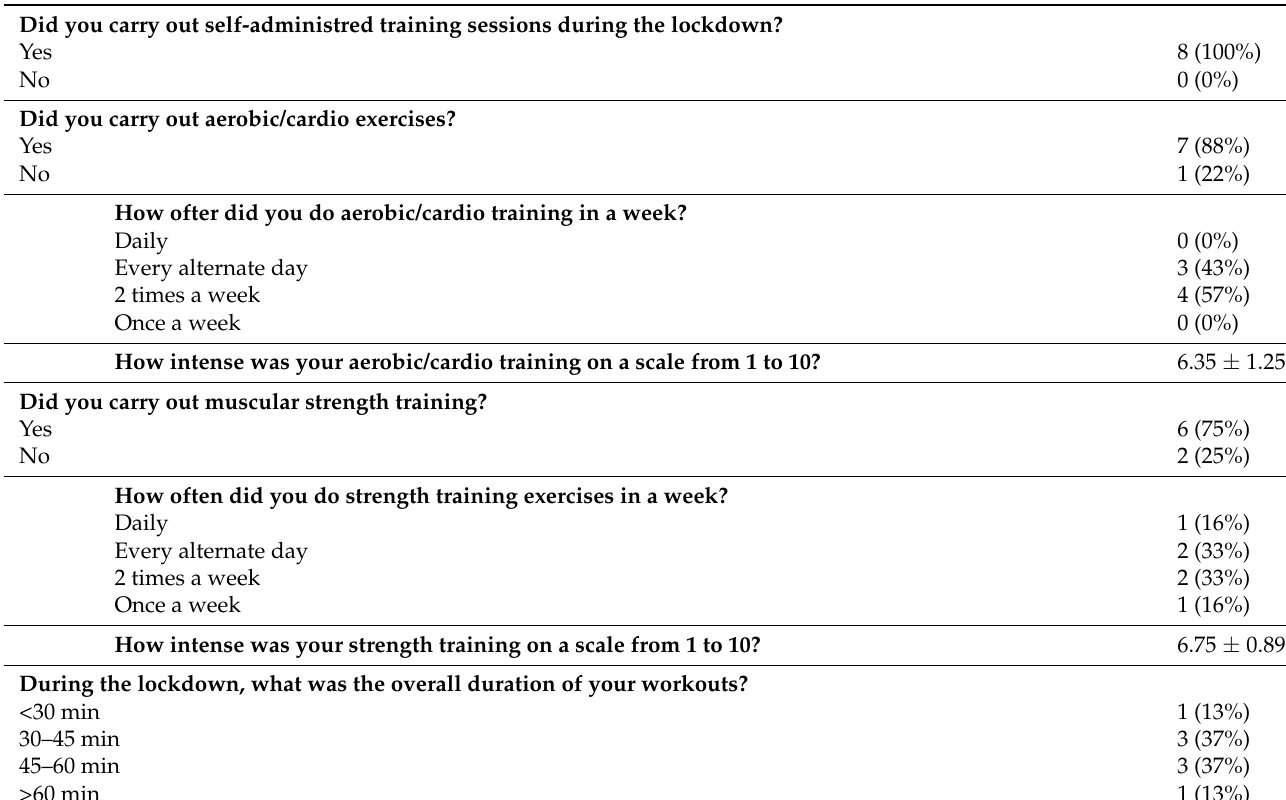
Table 1. The questionnaire administered to the athletes participating in the